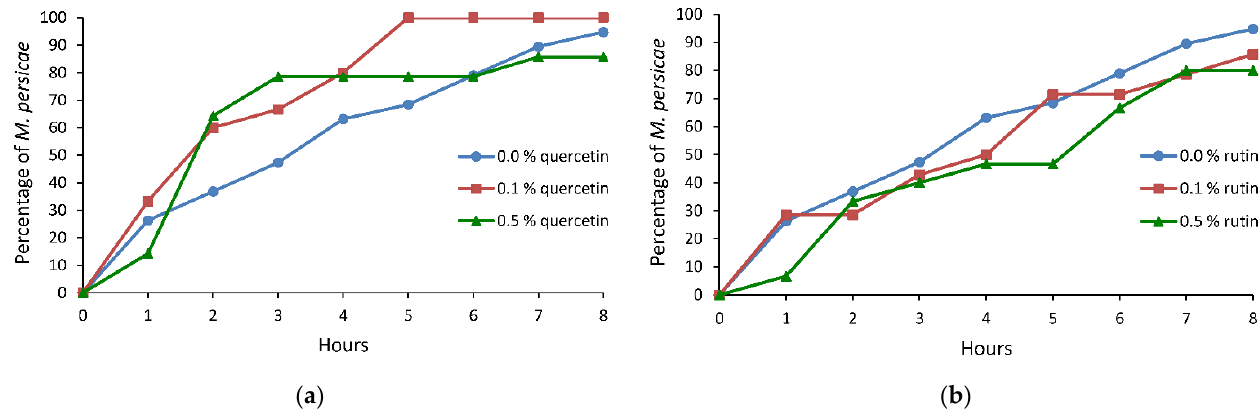
Figure 2. Cumulative proportion of Myzus persicae individuals that reached phloem sieve elements on Brassica rapa subsp. pekinensis treated with 0.0%, 0.1%, and 0.5% ethanolic solutions of ( a ) quercetin and ( b ) rutin.